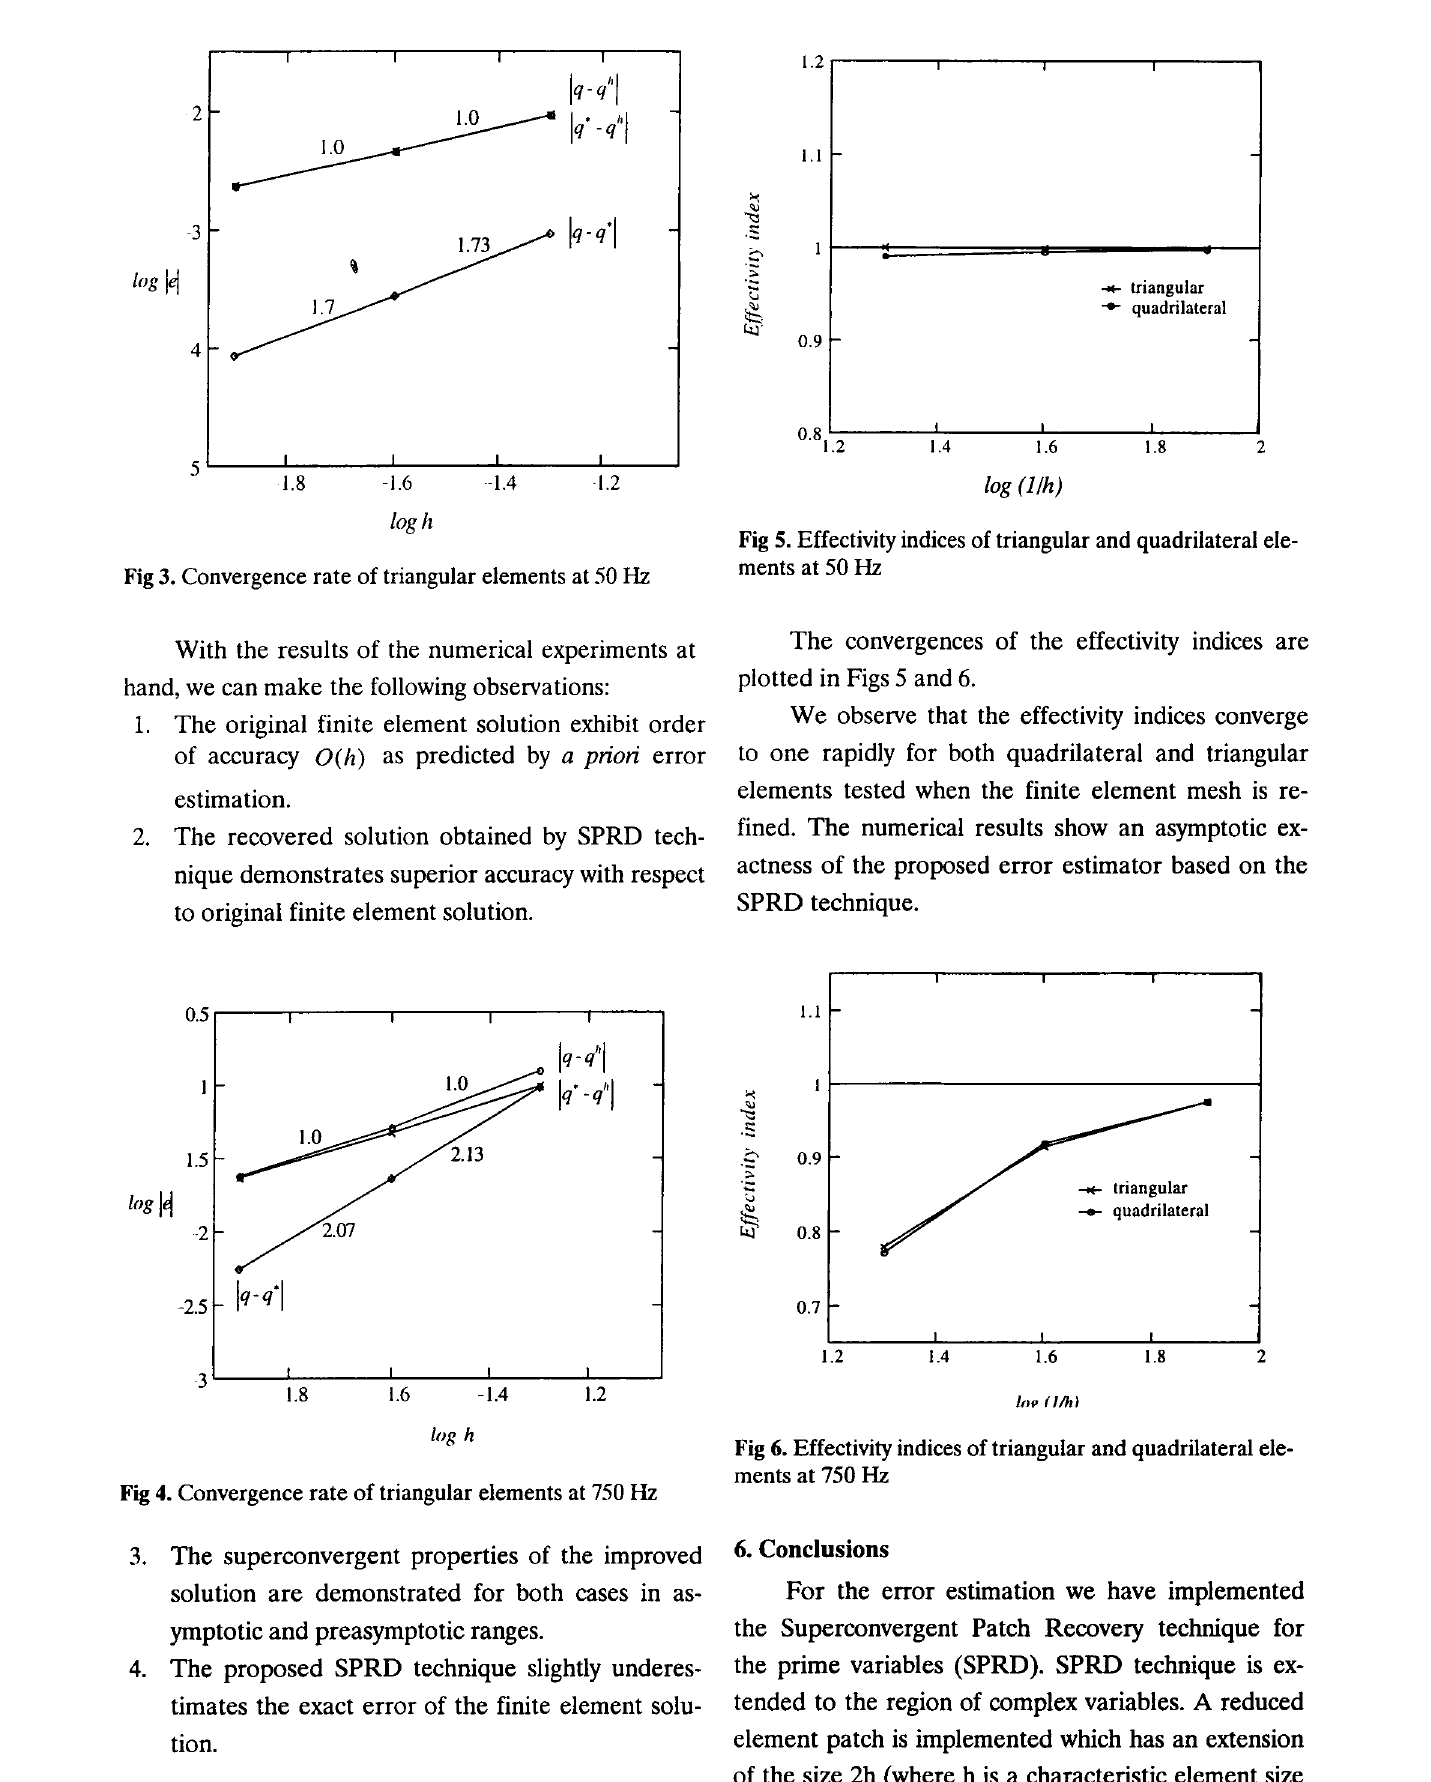
Fig 6. Effectivity indices of triangular and quadrilateral ele ments at 750